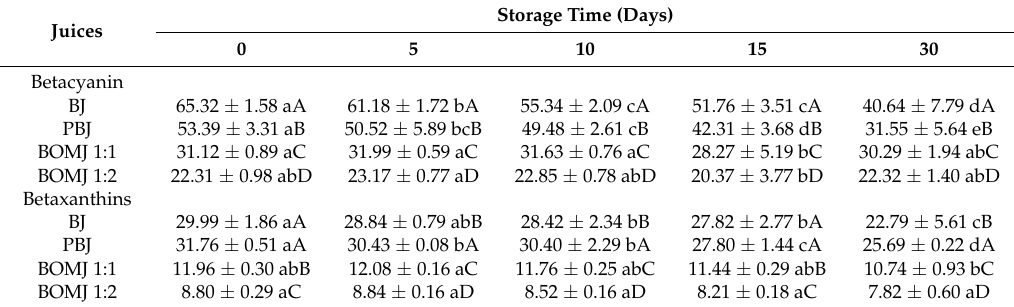
The values represent the mean ± standard deviation ( n = 9). Different superscript low-case letters in the same line indicate significant difference ( p < 0.05) for each juice in relation to storage time. Different superscript upper-case letters in the same column indicate significant difference ( p ≤ 0.05) between juices for the same storage day, BJ (raw beet juice), PBJ (pasteurized beet juice), BOMJ 1:1 (pasteurized beet and orange mix juice 1:1 ( v / v ) and BOMJ 1:2 (pasteurized beet and orange mix juice 1:2 ( v / v